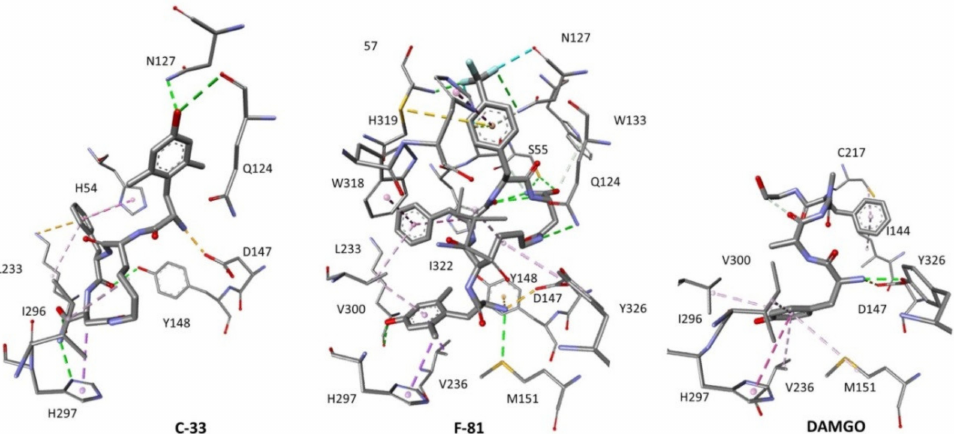
Figure 6. Side views of the predicted binding modes for peptides C-33, F-81, to the deposited structure of MOP (PDB ID: 6DDF), for comparison, the pose of DAMGO extracted from 6DDF is also shown [54]. The relevant receptor residue side chains are rendered in thick lines and the ligands in sticks; C is rendered in grey, N in blue, and O in red. Dashed green lines represent conventional hydrogen bonds, while cation– π interactions are rendered in yellow, π – π interactions in violet, hydrophobic interactions in white, and other interactions in